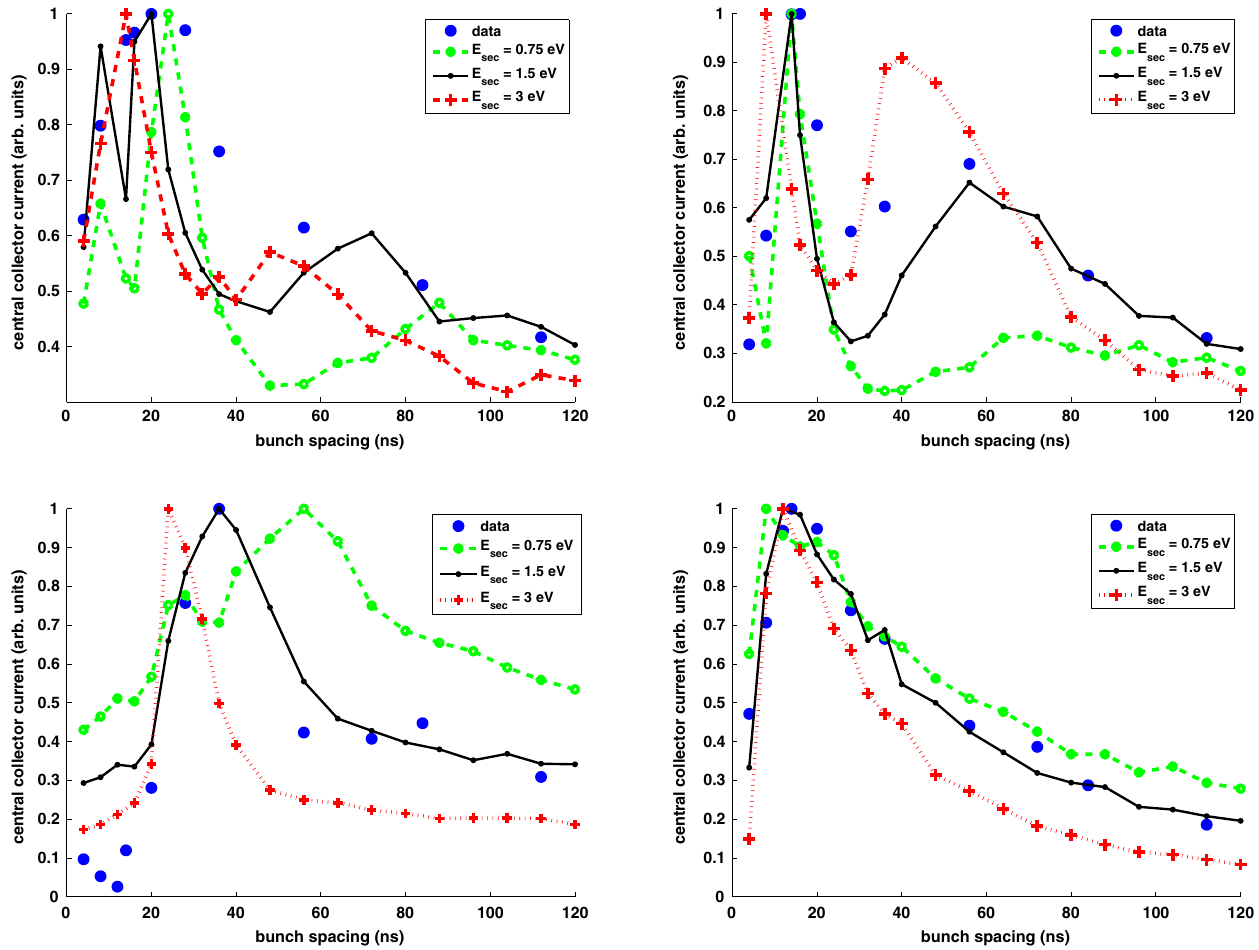
FIG. 12. Simulation of the multipacting resonances, compared to measurements, for different secondary emission energies. Top left: chicane RFA, 1.4 mA, e þ ; top right: chicane RFA, 3.4 mA, e þ ; bottom left: CESR dipole RFA, 1 mA e − ; bottom right: CESR dipole RFA, 3.4 mA, e − . All cases were done with 20 bunches, at beam energy 5.3